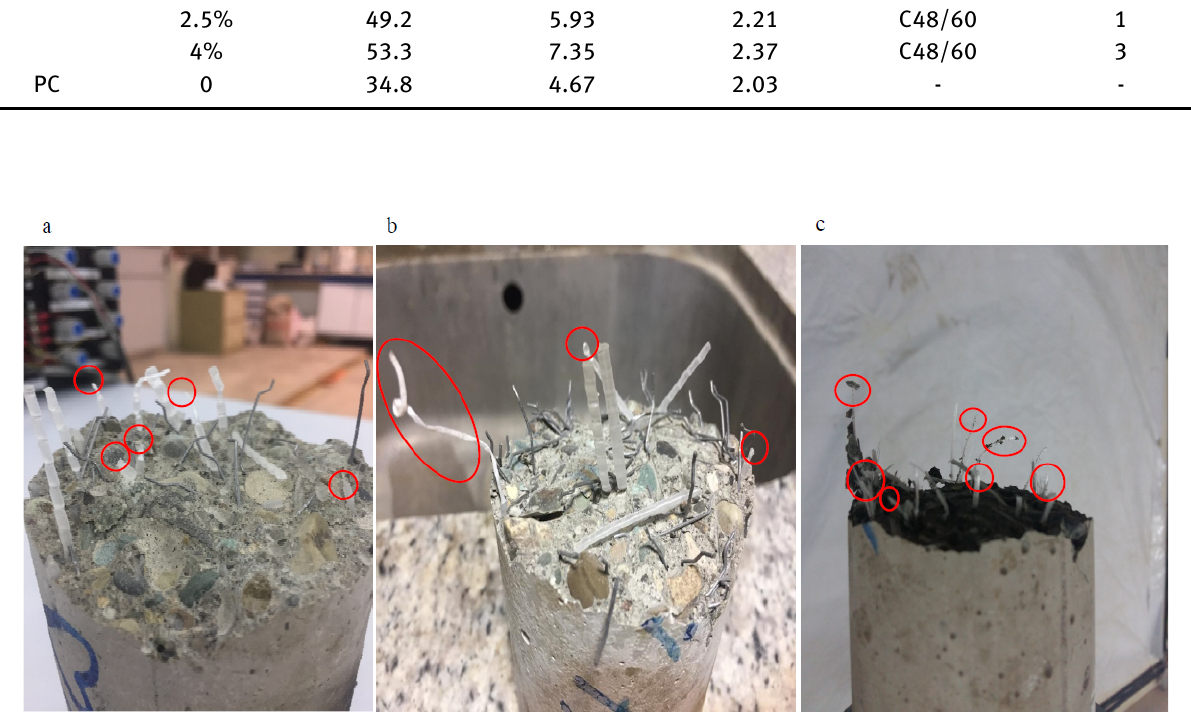
Figure 9: Different specimens following direct tensile testing (ripped polymer fibers are marked). a. Hybrid specimen with 50%PF+50%SF, b. Hybrid specimen 75%SF+25%PF, Hybrid specimen with 75% PF+25%SF. As can be seen, polymer fibers are mostly ripped yet steel fibers only stretched, were deformed or were pulled out